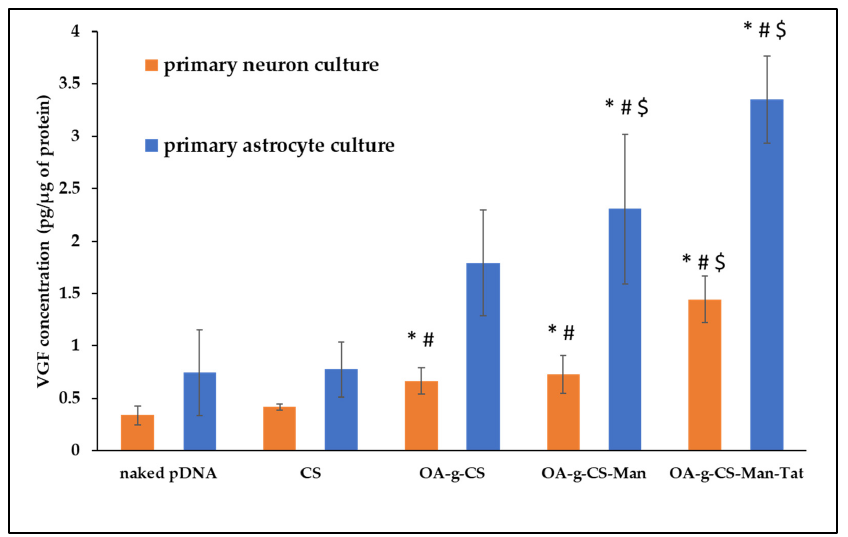
Figure 9. VGF expression levels in primary astrocytes and primary neurons after treatment with CS–pVGF, OA-g-CS–pVGF, and OA-g-CS-Man-Tat–pVGF polyplexes. Results presented as mean ± SD ( n = 4). (“*” indicates significantly ( p < 0.05) different from naked pDNA “#” indicates significantly ( p < 0.01) different from respective naked pDNA and “$” indicates significantly ( p < 0.001) different from respective naked pDNA).